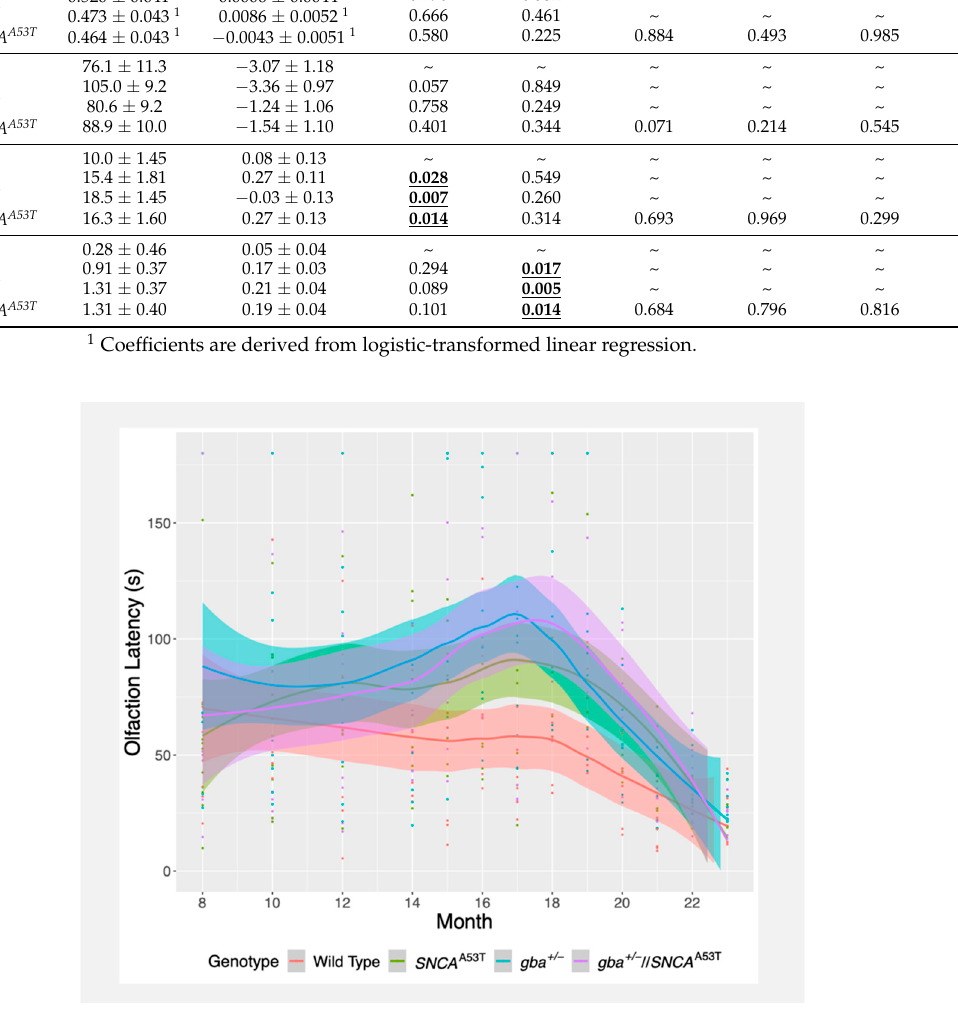
Table 1. Results of the longitudinal mixed-effects models for the three behavioral parameters assessed. p -values comparing both the intercept (9-month baseline score) and slope values between genotypes are provided. Significant p -values ( p < 0.05) are underlined and in bold. For all tests except the novel object recognition test, a more positive slope value indicates worsening performance over time.